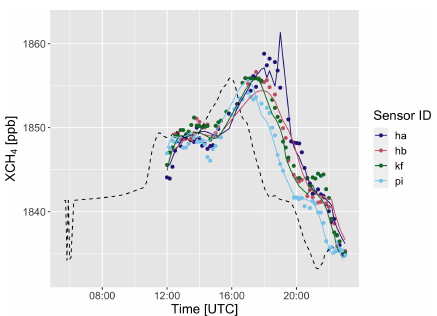
Figure 11. Observed XCH 4 values for 13 May (shown in points). Optimized domain boundary background values (gray, dashed) and optimized total column values, including urban emissions (colored lines), are also shown.